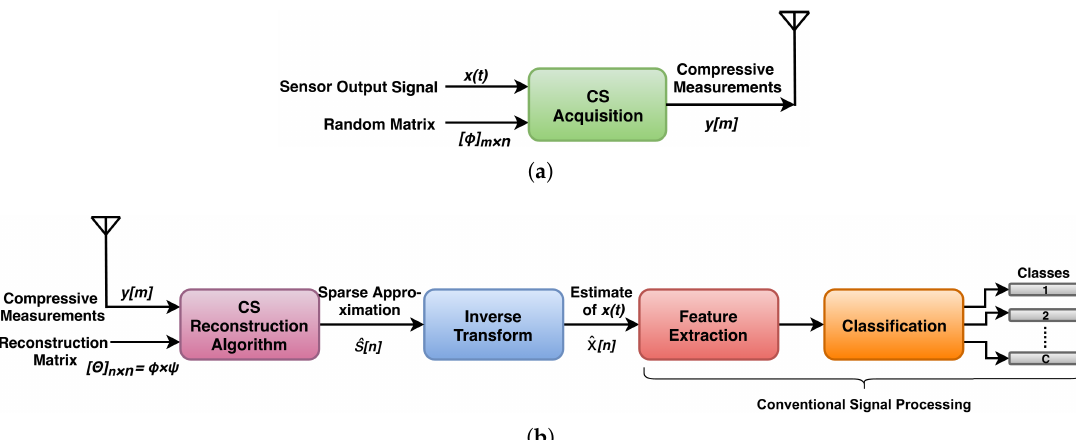
Figure 2. Scenario representing WSN implementation using conventional CS technique: ( a ) sensor node and ( b ) base